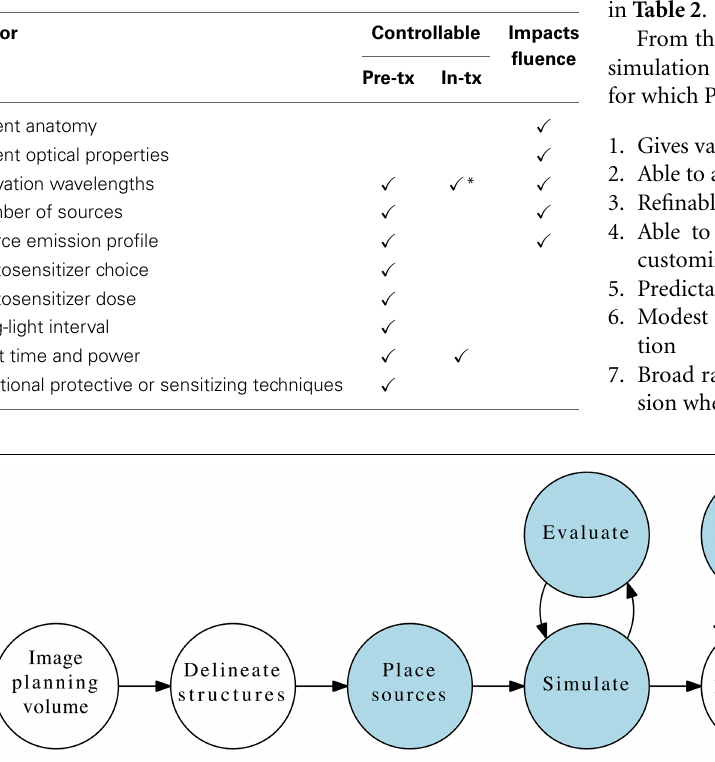
Frontiers in Physics | Biomedical